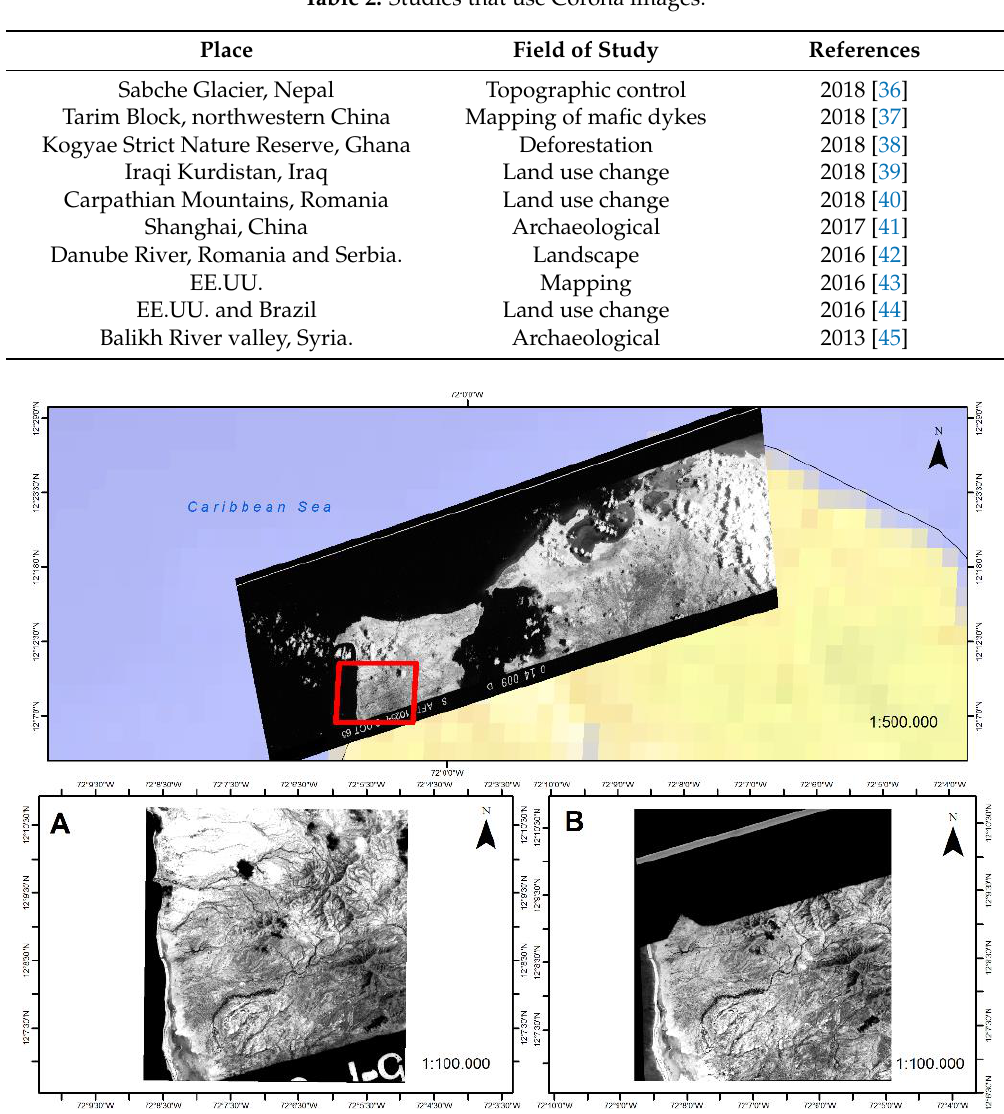
Figure 3. Stereoscopic images ( A , above; B , below) from the Corona KH-4A satellite, 6 October 1965 of Cabo de la